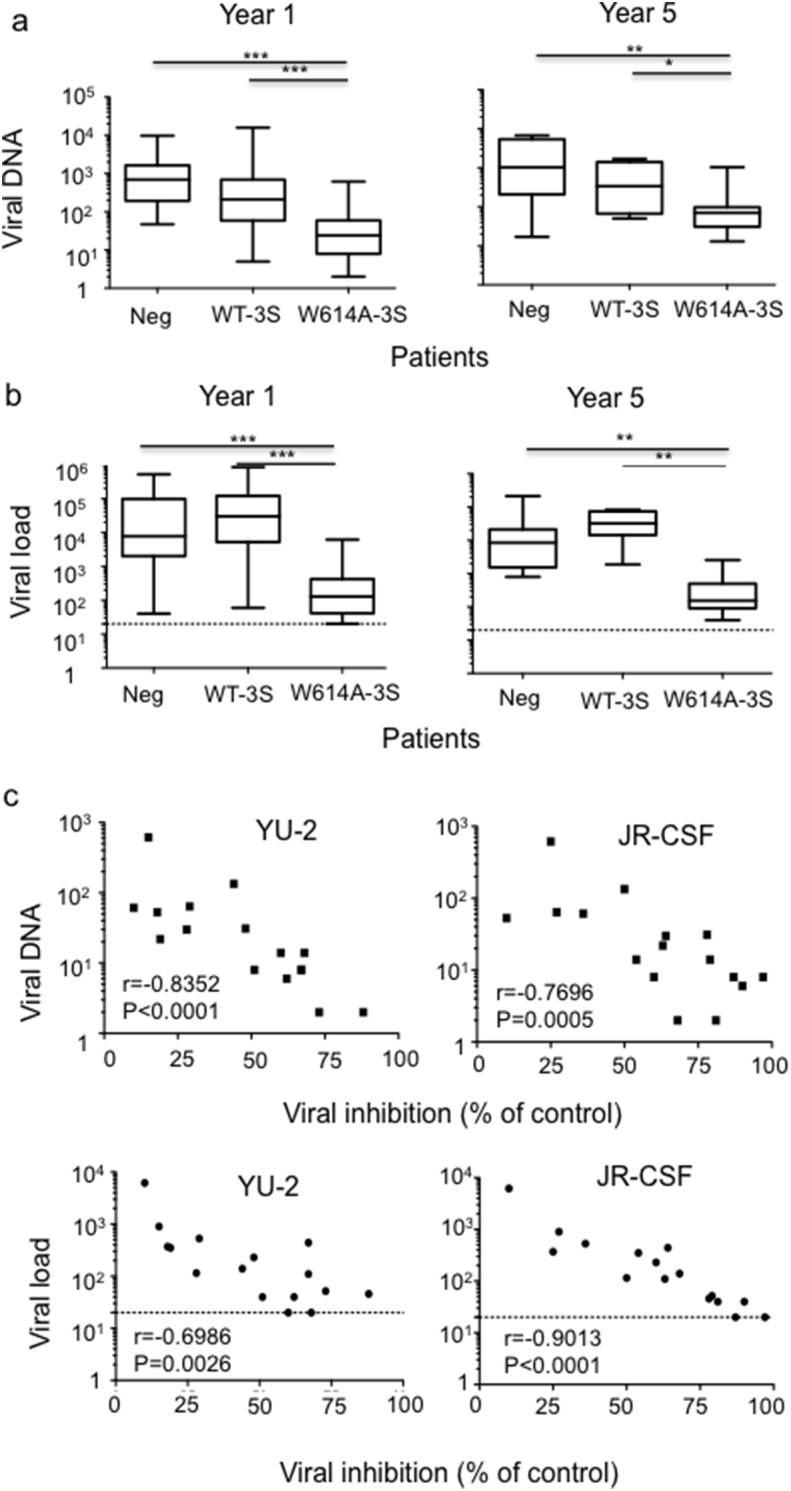
Robust decrease in RNA viral load and viral DNA in LTNP patients producing W614A-3S NAbs. (A) Viral DNA in LTNP patients subdivided into three groups according to their capacity to produce W614A+-3S NAbs, non-neutralizing WT-3S+ Ab only, or neither subtype (Neg). Data are done at years 1 and 5 after cohort entry. (B) RNA viral load in the different groups of LTNP patients at years 1 and 5 after cohort entry. (C) Correlations between RNA viral load, viral DNA and neutralizing activity of purified W614A-3S NAbs from the 16 ALT patients against JR-CSF and YU-2 HIV-1 strains at year 1 after cohort entry. Neutralizing activity was measured as the percentage of viral inhibition compared with the control. Dotted lines indicate the limit of detection of viral load.